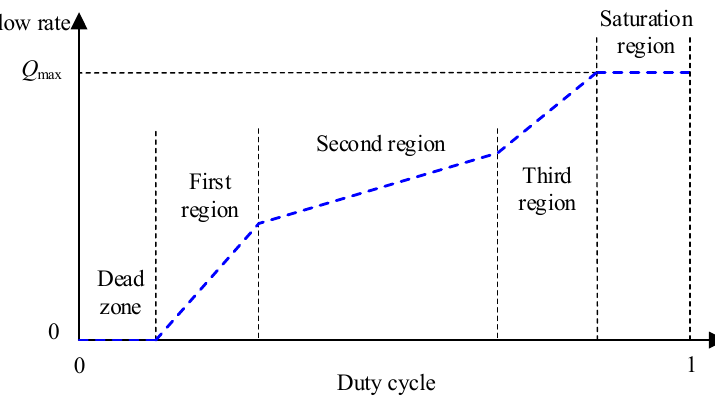
Figure 3. Static flow characteristics of an HSV.